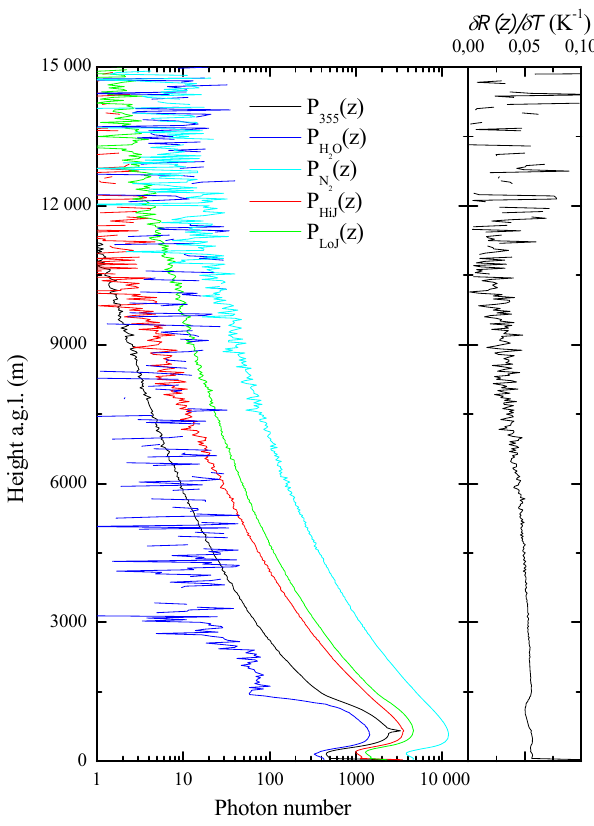
Figure 2. (a) The mean photon numbers (10s average) for the con- sidered signals, i.e. the water vapour and molecular nitrogen vi- (z) and P N (z) , the 355nm elas- brational Raman signals, P H 2 2 O tic signal, P 355 (z) and the pure-rotational Raman signals, P LoJ (z) and P HiJ (z) ; (b) temperature sensitivity of RRL measurement tech- nique. ∂R(z)/∂T